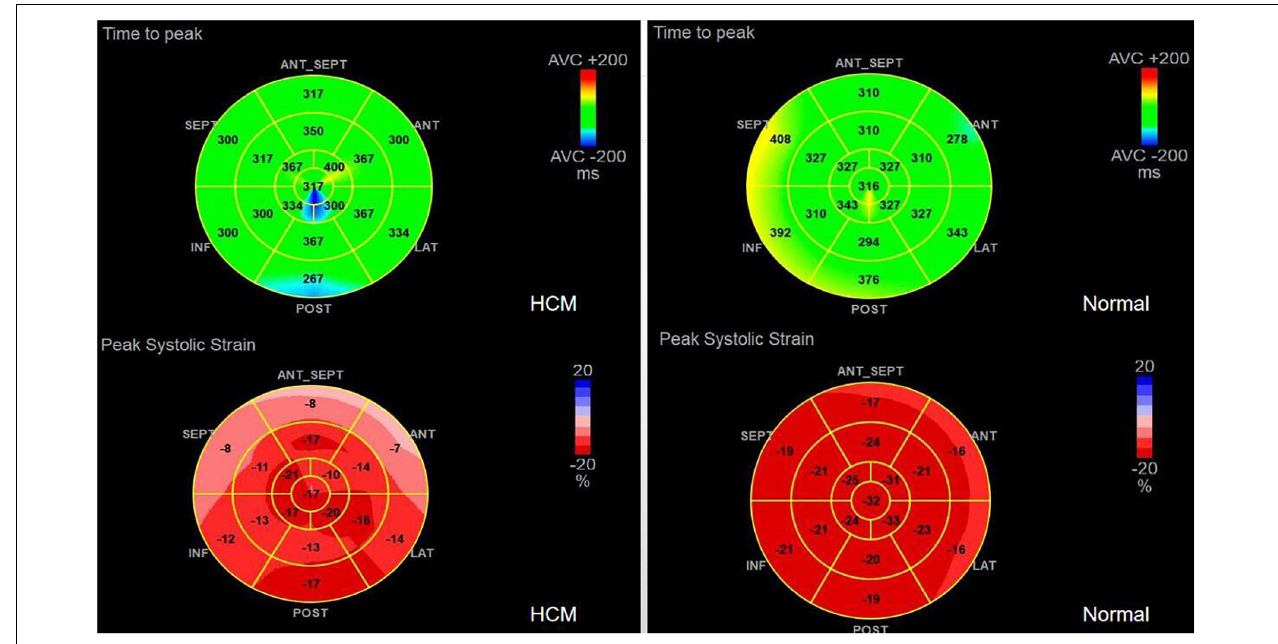
FIGURE 1 | PSD AND PSS in HCM and Normal group.